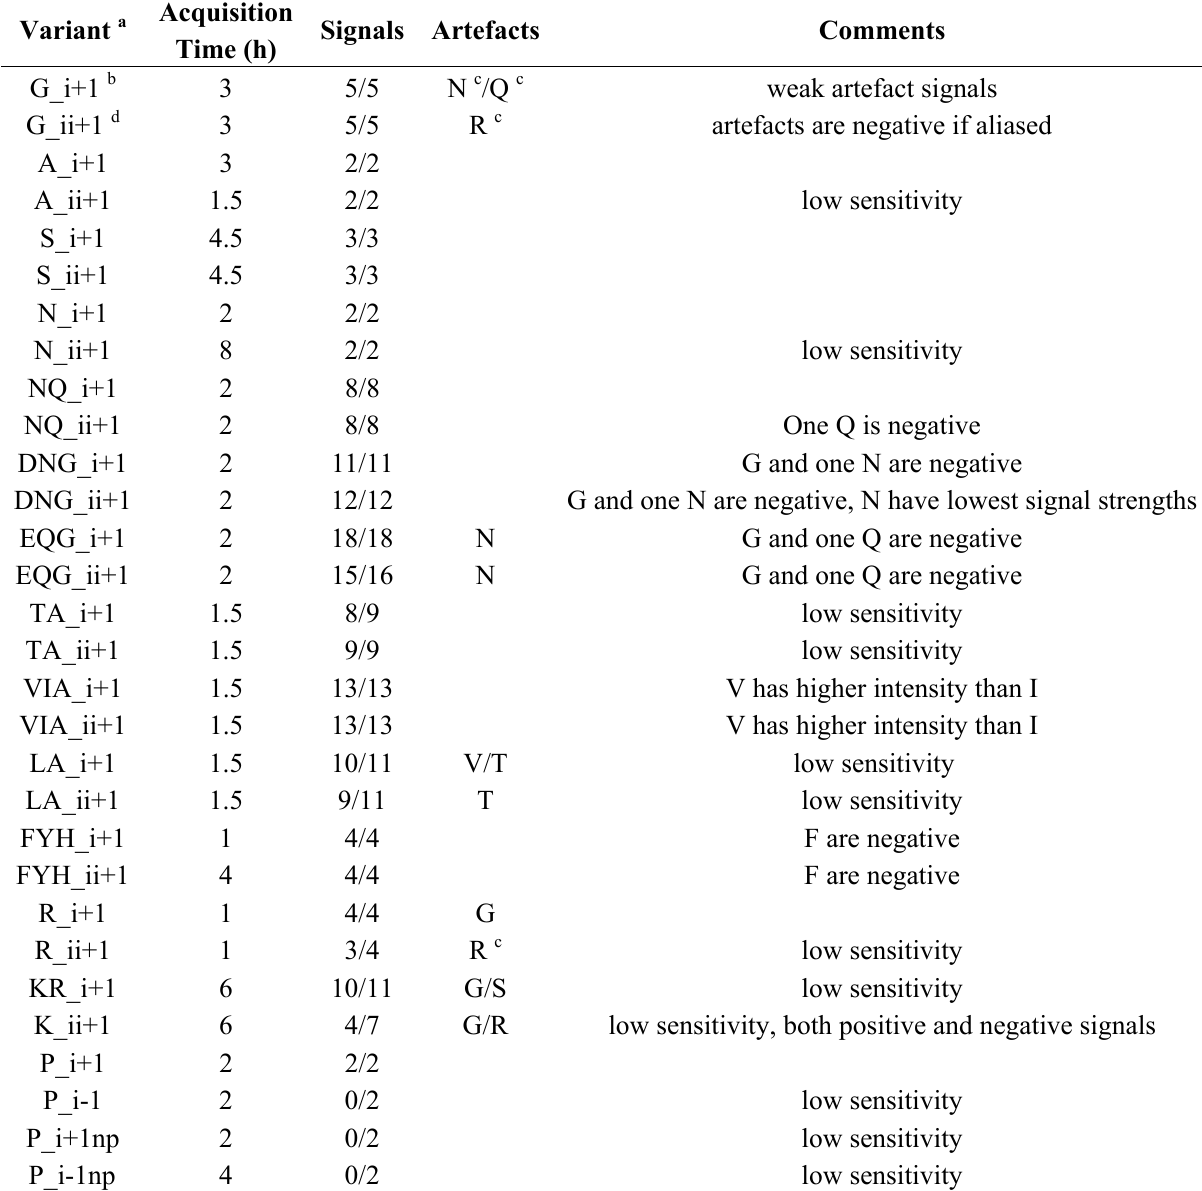
Table 2. Overview of 30 MUSIC experiments that were acquired on human ubiquitin. Variant